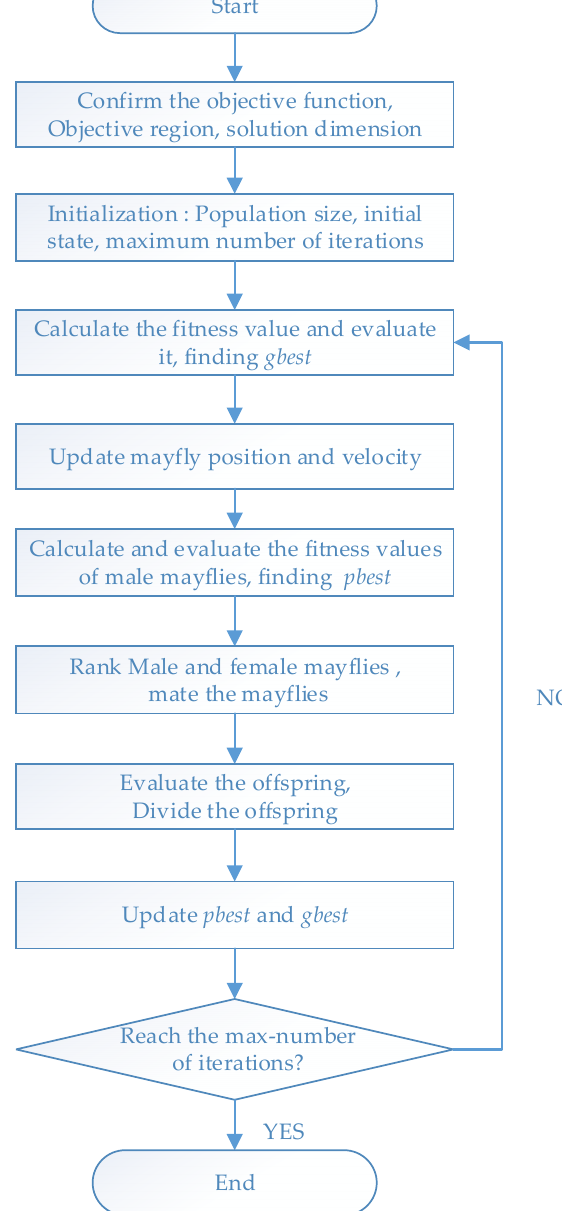
Figure 2. Flow chart of MOA station deployment for hybrid positioning.